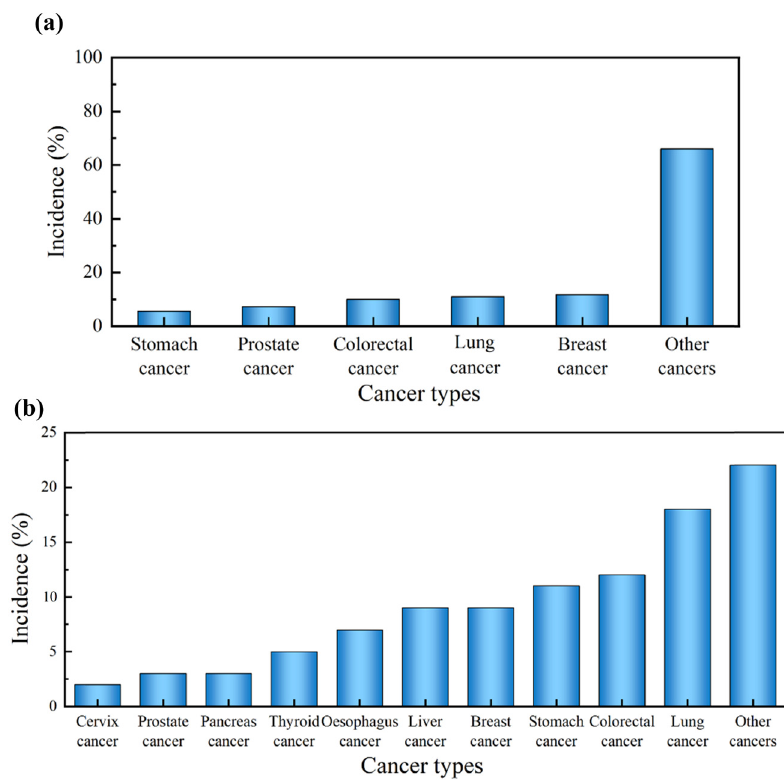
Figure 1: The incidence of cancers in the world ( a ) and China ( b )